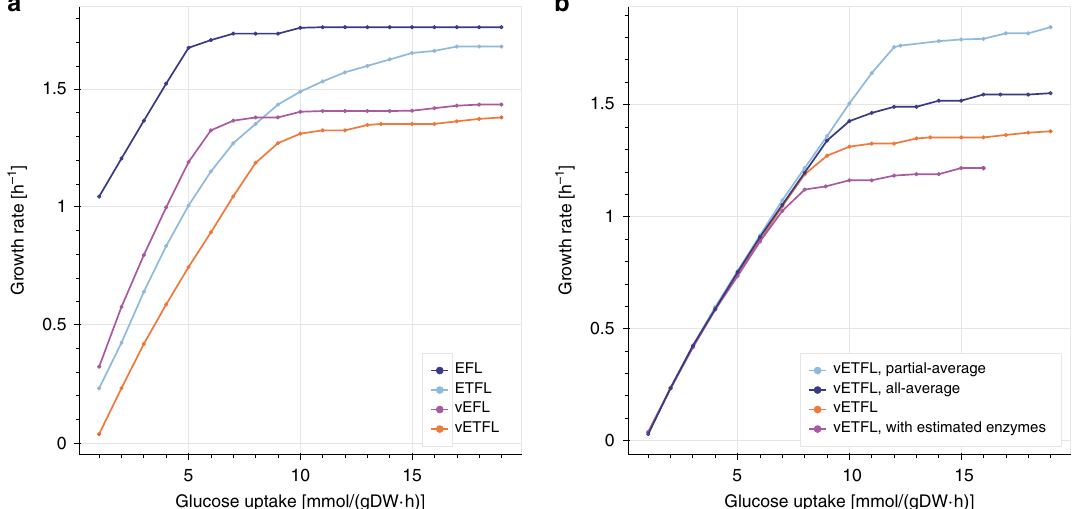
Fig. 1 Growth rate with respect to glucose uptake for differently constrained models in the ETFL framework. Legend in the same order as the height of the right-most point of each curve in each fi gure. a Growth rate predictions using the EFL, ETFL, vEFL, vETFL models (dark blue, light blue, purple, orange); b growth rate predictions accounting for missing enzymes using vETFL (orange) and models (i) – (iii) (purple, dark blue, light blue) representing different initial enzyme assumptions, with k values obtained from vETFL or k 172 h (cid:4) 1 , and with/without inferred cat cat ¼